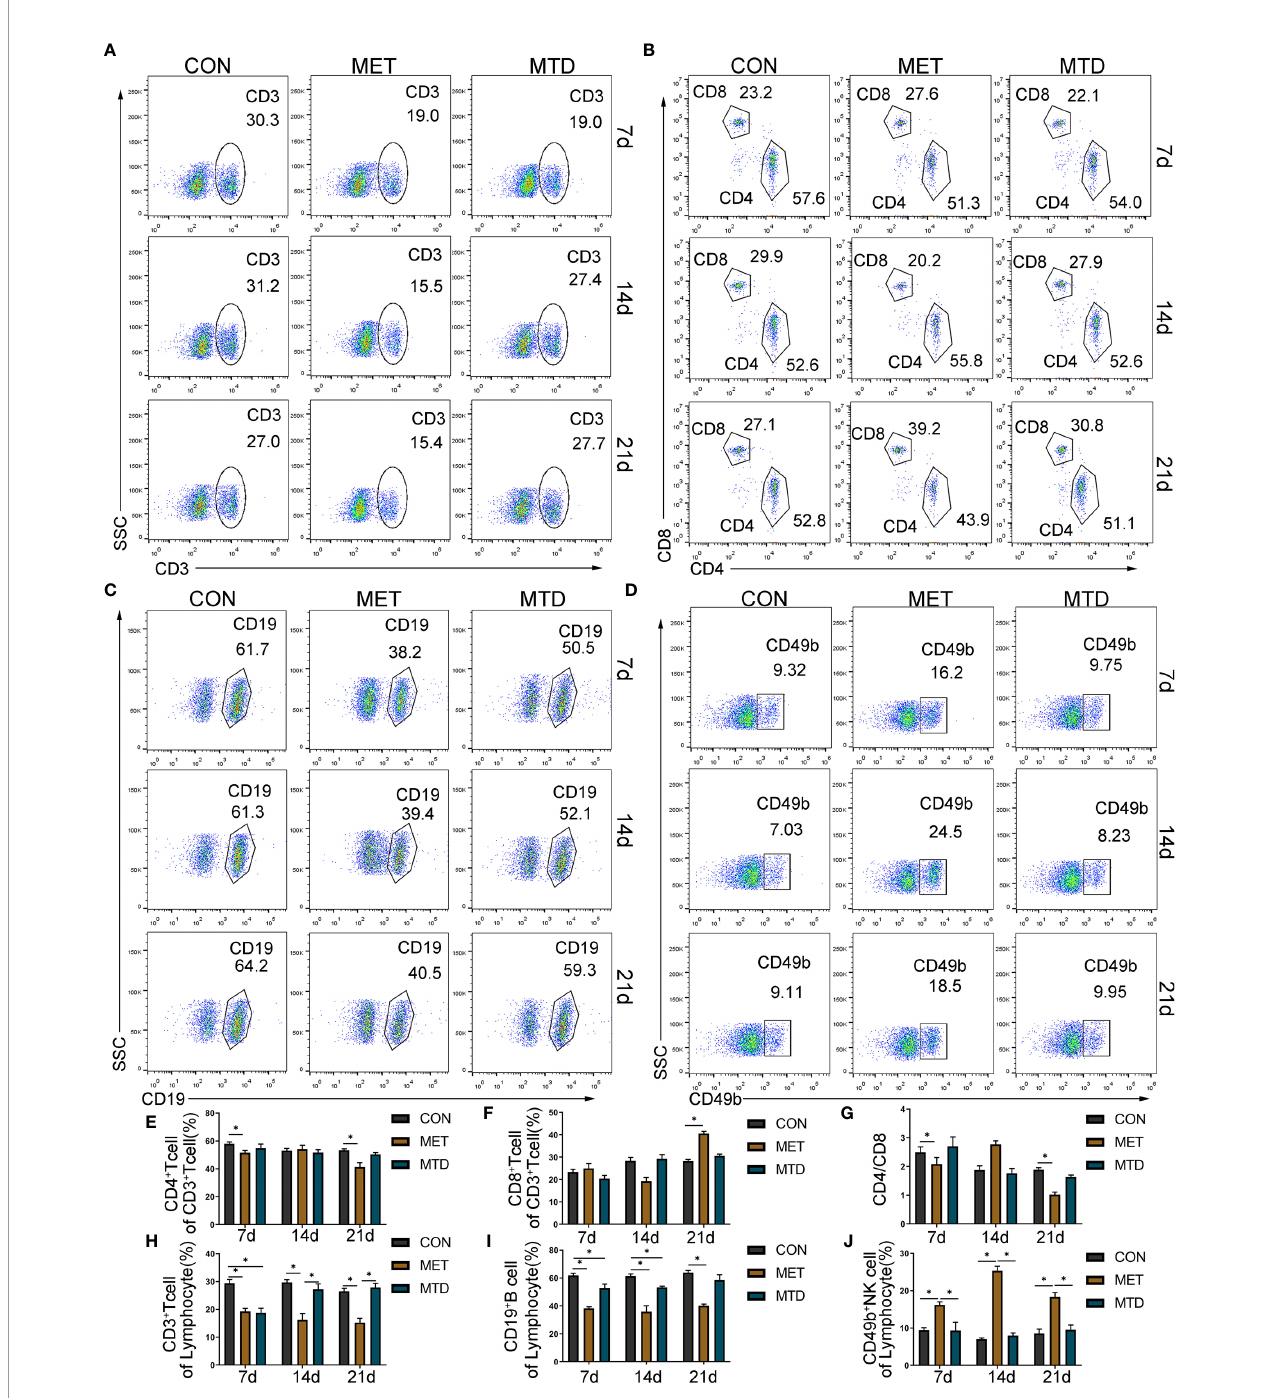
FIGURE 2 | Proportion of lymphocyte subsets in the spleen of mice. The percentage of CD3 + T cells in lymphocyte (A, H) ; the percentage of CD4 + T cells (B, E) and CD8 + T cells (B, F) in CD3 + T cells; the ratio of CD4/CD8 (B, G) ; the percentage of CD19 + B cells (C, I) and CD49b + NK cells (D, J) among lymphocytes, as detected by fl ow cytometry. CON: control groups, in which mice received 0.9% normal saline. MET: CAP-treated groups in which mice received metronomic chemotherapy dose of CAP (100 mg/kg/d). MTD: CAP-treated groups in which mice received maximum tolerated dose of CAP (400 mg/kg/d). Data are shown as mean ± SD. * P <